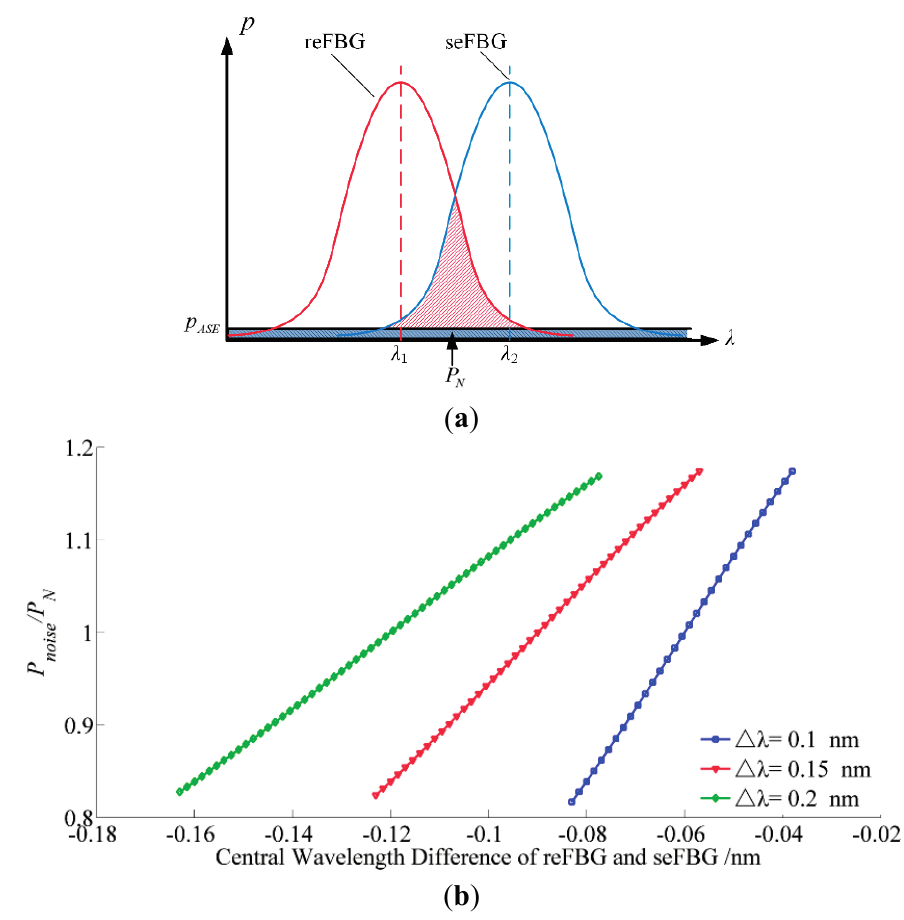
Figure 5. Analysis of the noise power introduced by ASE broadband source: ( a ) Principle of the noise level analysis; ( b ) the relation between / difference in the most sensitive section with the nonlinearity of